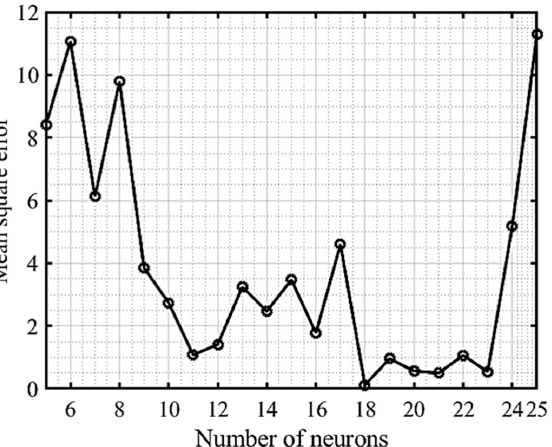
Figure 4. The performance of the network at different hidden neurons using a Bayesian regularization algorithm.